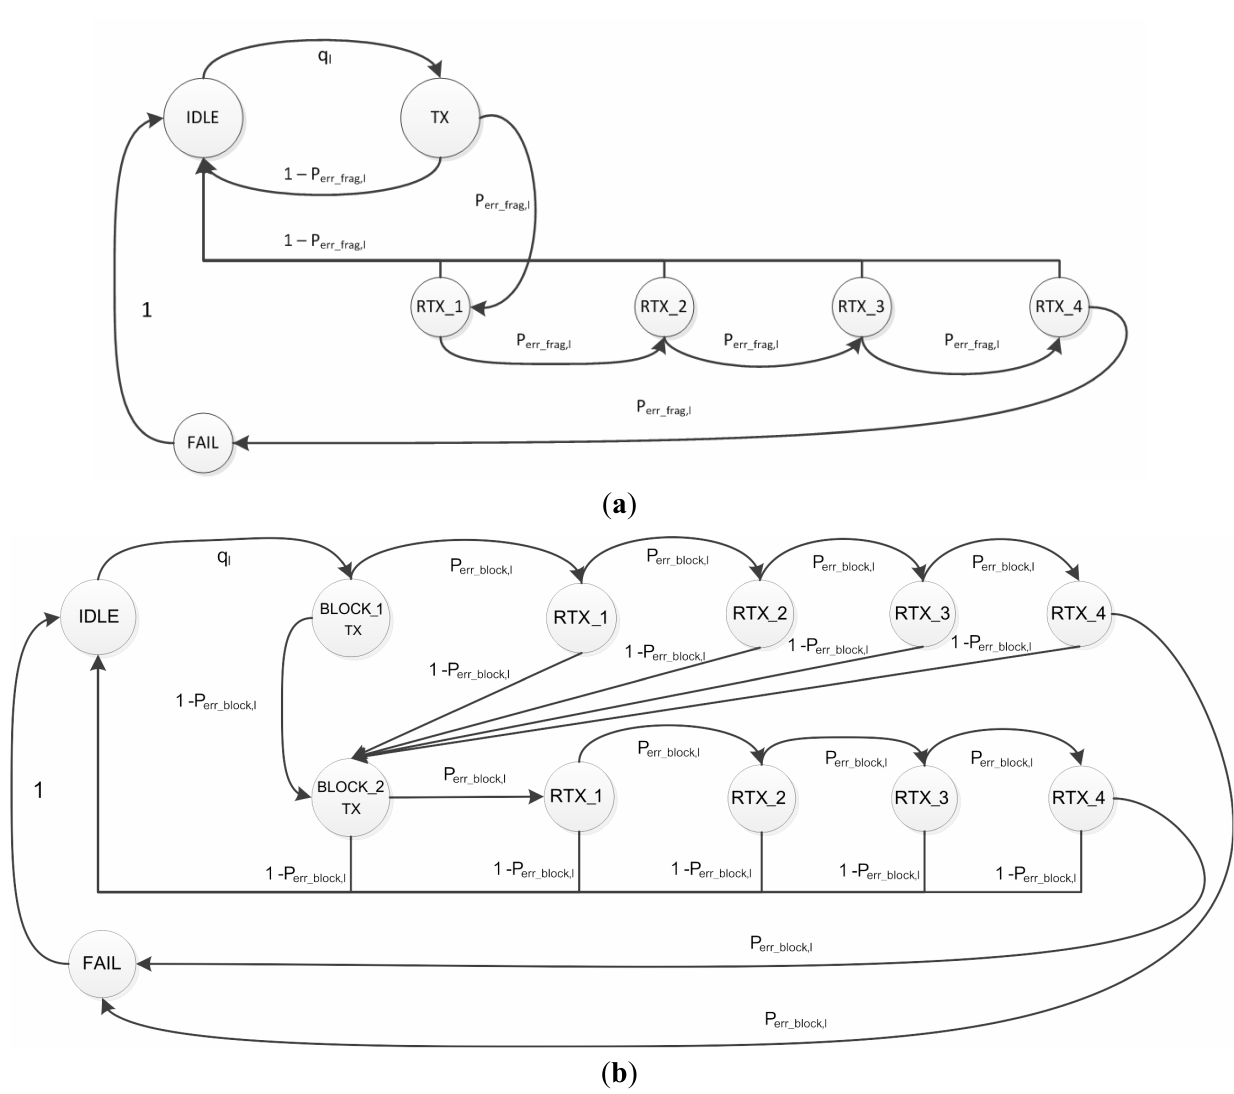
Figure 6. Markov chains for the server. ( a ) 6LoWPAN Fragmentation case ( b ) Blockwise transfer case. ( a ) The server retransmits all the fragments if the transmission of any of them fails or it does not receive the CoAP ACK; ( b ) The server retransmits a single block if its transmission fails or it does not receive the relative CoAP ACK. The Markov chain represents the transmission of an observe update composed by two